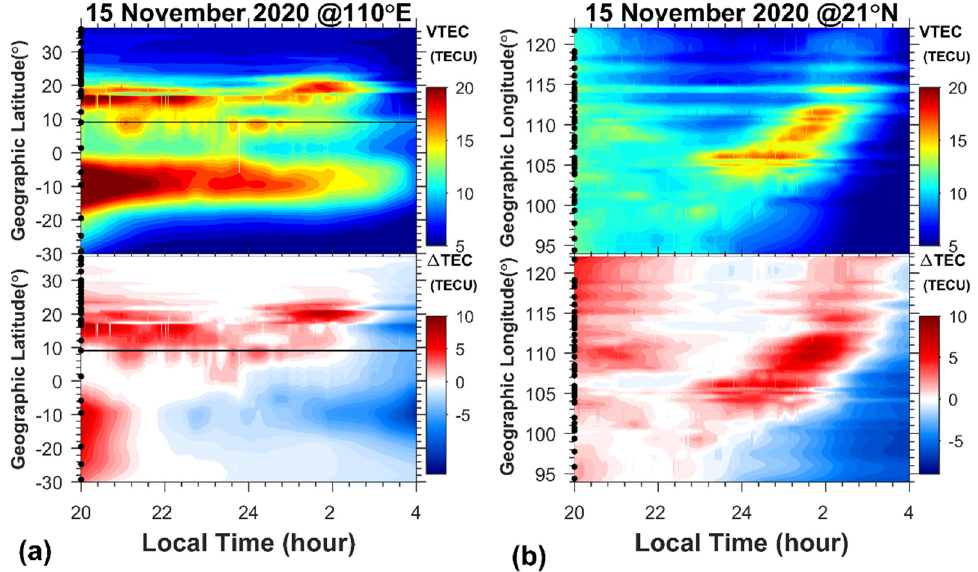
∆ TEC ( a ) at 110 ◦ E and ( b ) at 21 ◦ N from 20 LT on Figure 6. Contour maps of GEO TEC and Δ TEC ( a ) at 110° E and ( b ) at 21° N from 20 LT on 15 Figure 6. Contour maps of GEO TEC and